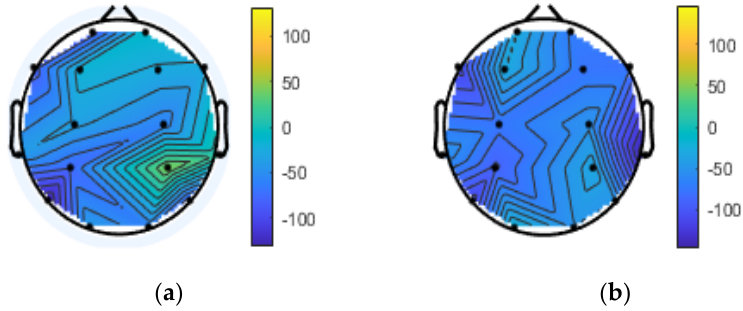
Figure 3. Topographical plot of theta frontal region. ( a ): left side of the frontal region representation for the HERA retrieval equation; ( b ): right side of the frontal region representation for the HERA retrieval equation.